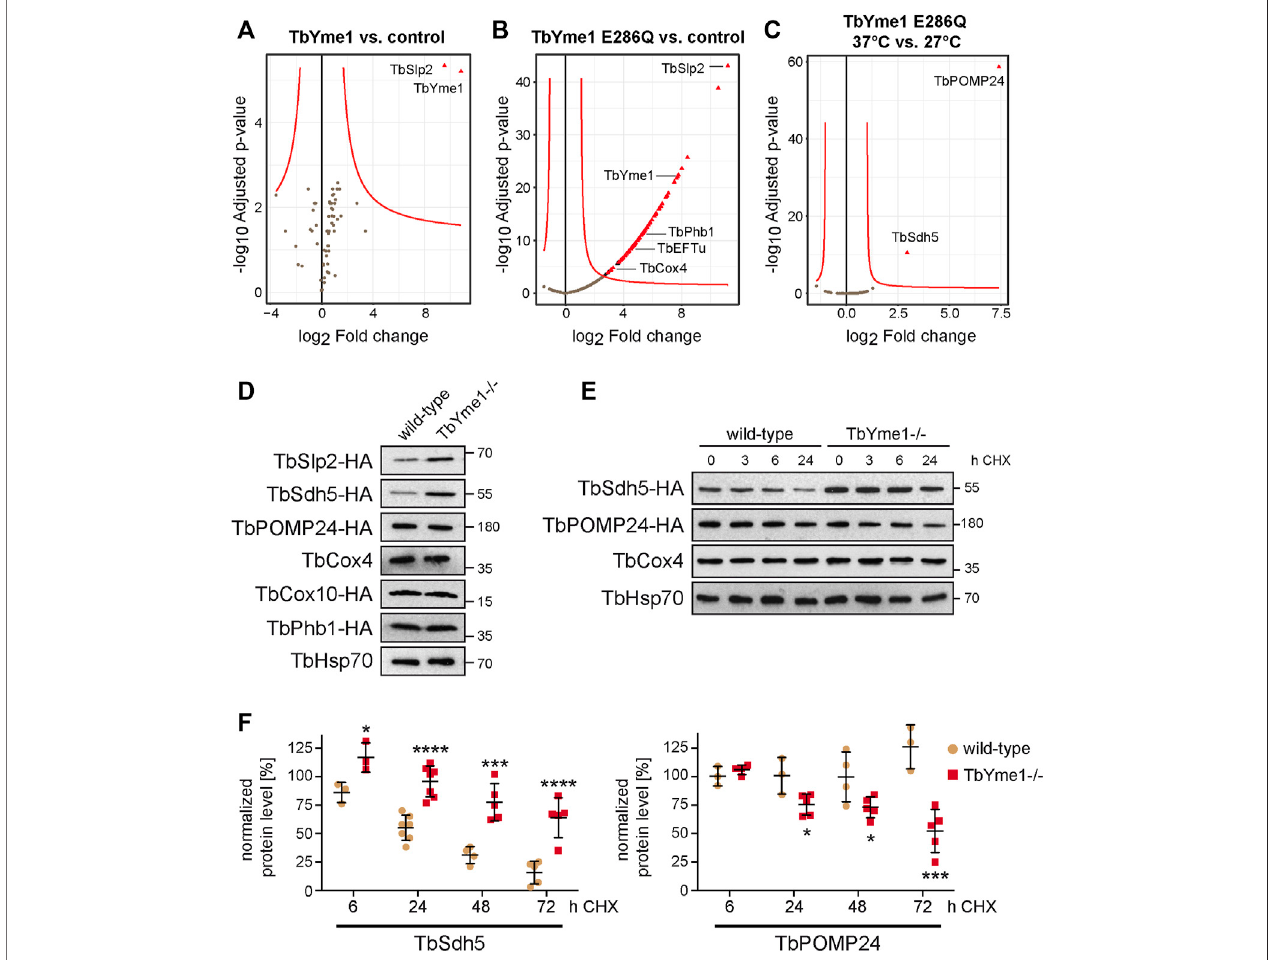
FIGURE6 | TbYme1 differentially affects its binding partners. Volcano plot ofproteins that were enriched after immunoprecipitation ofTbYme1-Myc (A) , TbYme1- Myc E286Q at 27 ° C (B) and after a heat-pulse of 37 ° C for 2 h (C) compared to parental untagged cells. Cut-off was set to 0.05 < p with a fold-change > 2.5 (red line). Resultsfrom A)and C)depictresults ofduplicate biologicalreplicates, while B)wasdone intriplicate. (D) PutativeTbYme1-interactingproteins were insitu HA-taggedin wild-type and TbYme1 − / − parasites and the protein levels were analysed by SDS-PAGE and immunoblotting. (E) Protein analysis by SDS-PAGE and immunoblotting after cycloheximide treatment of wild-type and TbYme1 − / − parasites expressing TbSdh5-HA or TbPOMP24-HA. (F) Quanti fi cation of the protein levels of TbSdh5-HA (left panel) and TbPOMP24-HA(rightpanel) after 6, 24, 48and 72 h ofcycloheximide treatmentfrom the experiment shown inE). Values representsignal intensities normalized to TbHsp70. Students t-test; *: p < 0.05; ***: p < 0.005; ****: p <